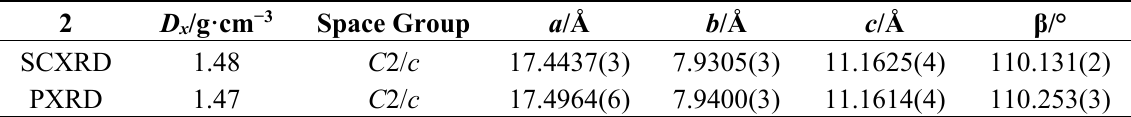
Table 4. Comparison of lattice parameters determined at 233 K (single crystal X-ray diffraction data) and 298 K (powder X-ray diffraction data).